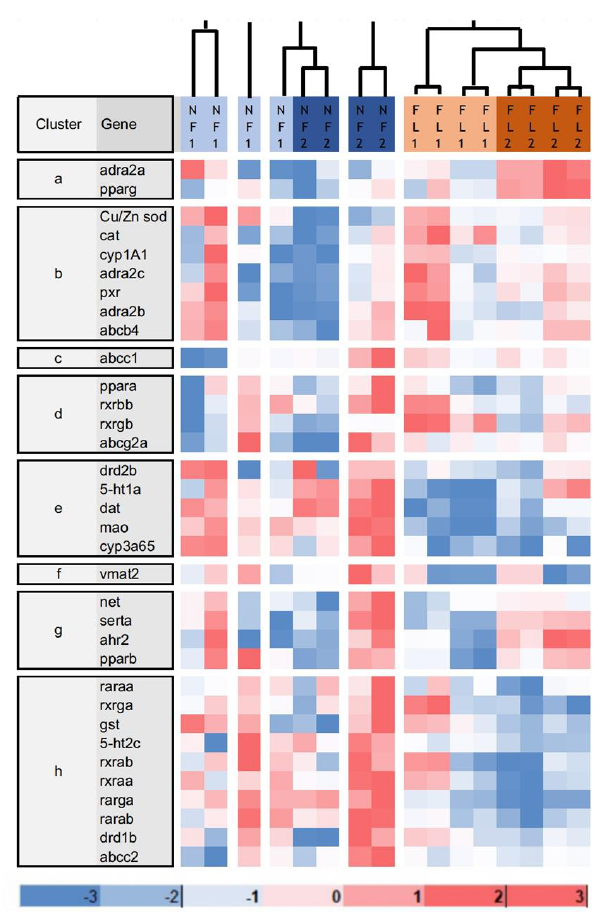
Figure 3. Heatmap of normalised gene expression (fold change) obtained for zebrafish larvae exposed to NF and FL for 80 hpf. The magnitude and direction of variation, relative to the solvent control, are indicated by the colour scale.